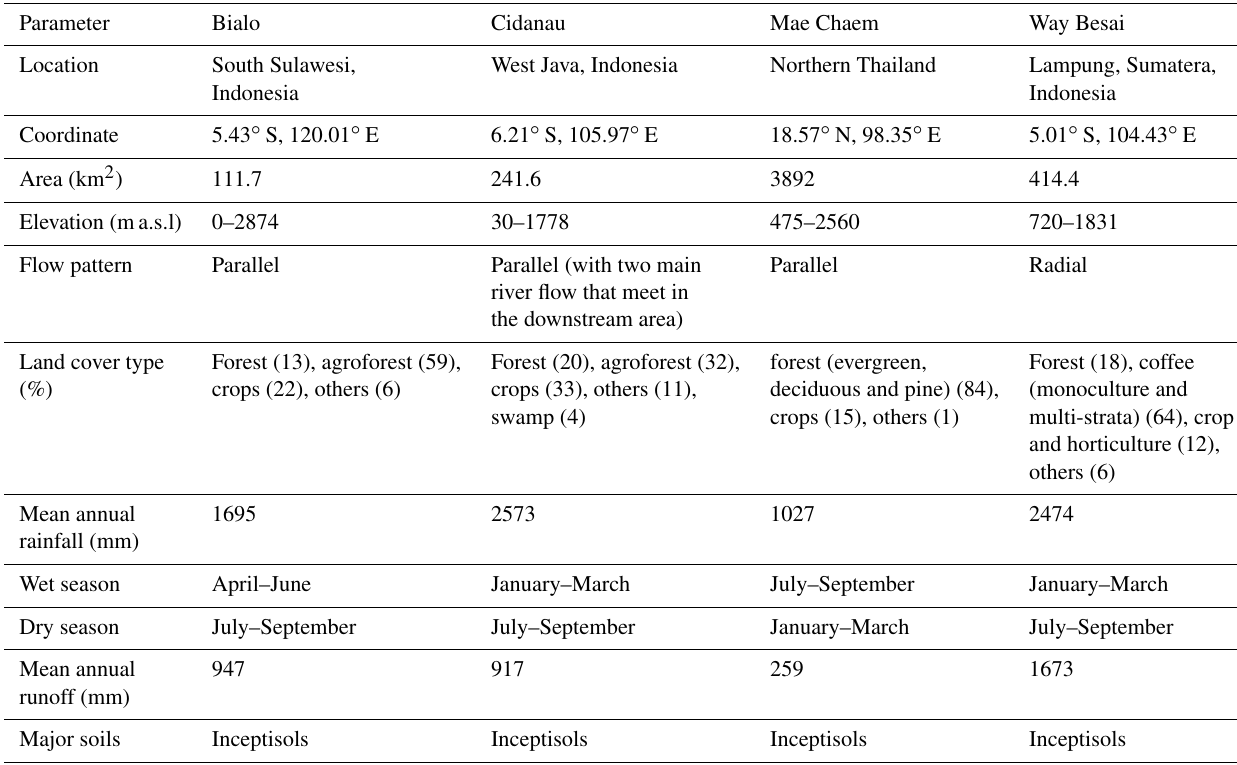
Table 1. Basic physiographic characteristics of the four study